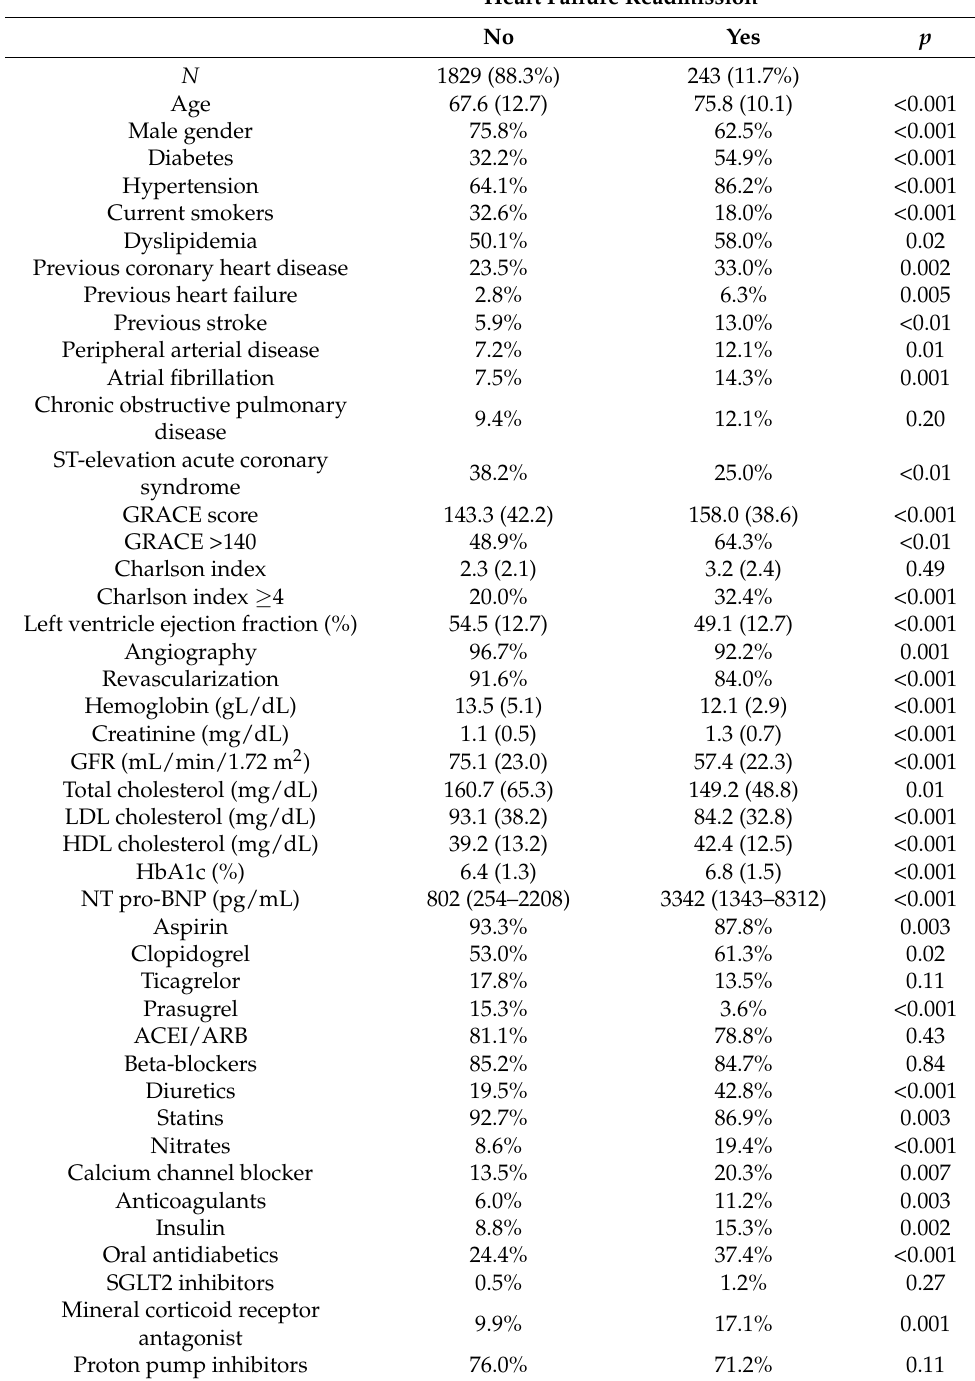
Table 2. Clinical features and medical treatments at discharge of the cohort according to whether they had any hospital readmission for heart failure or